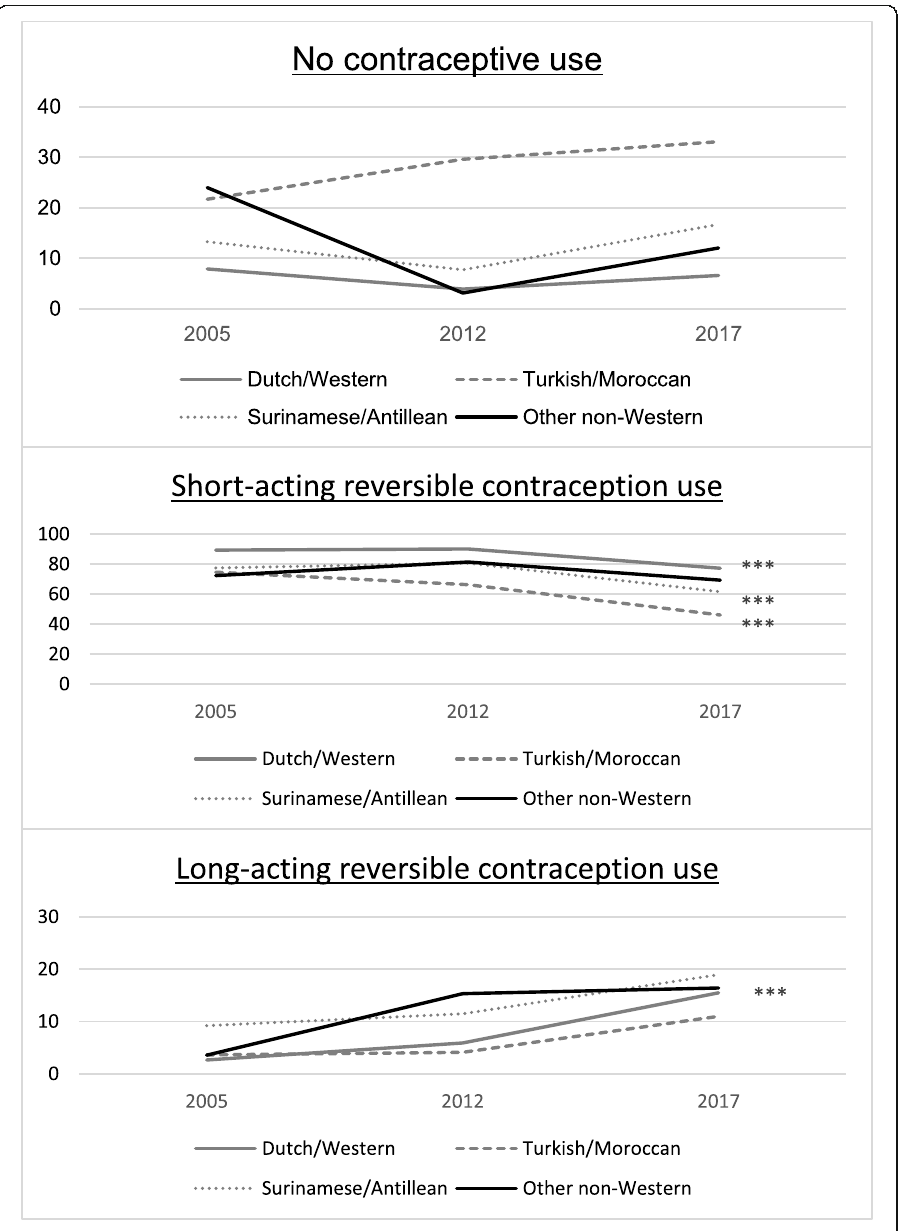
Fig. 5 Trends over time in contraceptive use by ethnic background. Trends did not differ significantly by ethnic group (p=.063). # Numbers in some groups are small, explaining the large proportional differences tha show no statistically significant trend. Significance indicated; ** p <0.01, *** p